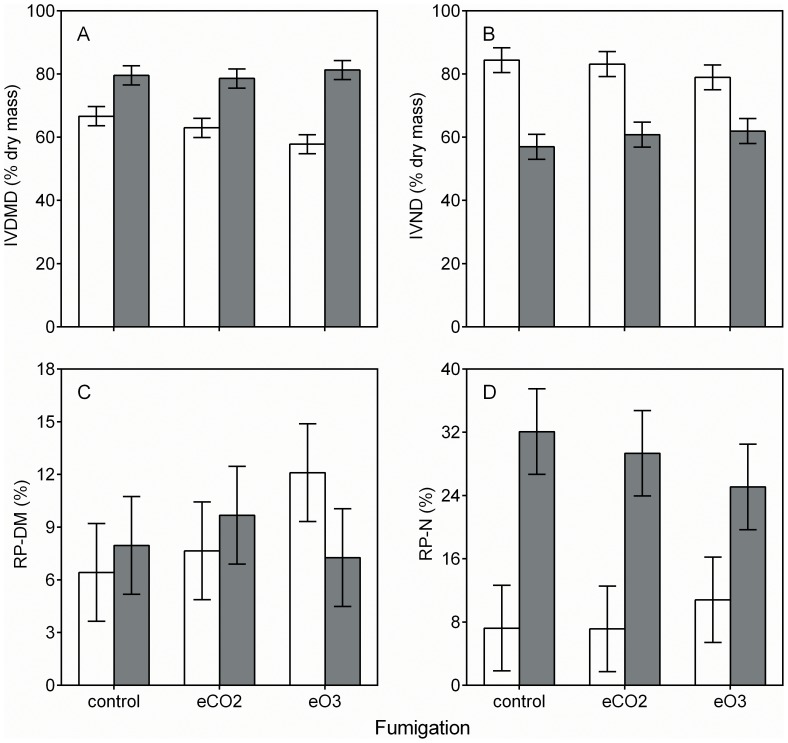
Fumigation and plant species effects on IVDMD, IVND, RP-DM, and RP-N.White and gray bars indicate least square means ±SE (n = 3 replicate FACE rings for each group mean shown) for S. candensis and T. officinale, respectively. Means for IVDMD, IVND, and RP-N, but not RP-DM differ between species (P  =  <0.05). Split-plot ANOVA results for these data are shown in Table 1.